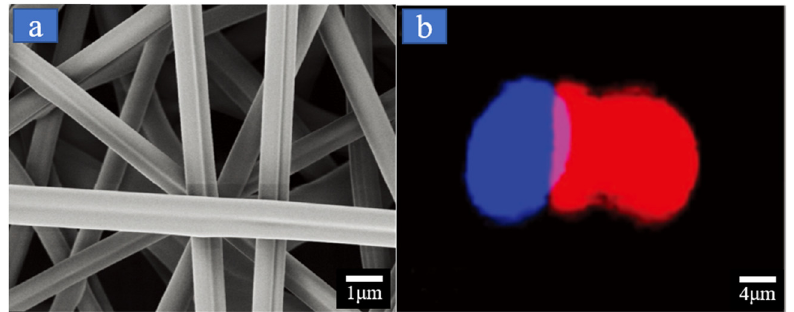
Figure 8: SEM image and AFM topography image of side - by - side bicomponent fi bers made from P ( MMA - co - BMA ) and PNiPAAm ( a ) SEM image and ( b ) Roman cross - section of the side - by - side bicomponent fi bers. Adapted with permission ( 124 ) Copyright 2017, WILEY - VCH Verlag GmbH & Co. KGaA, Weinheim.